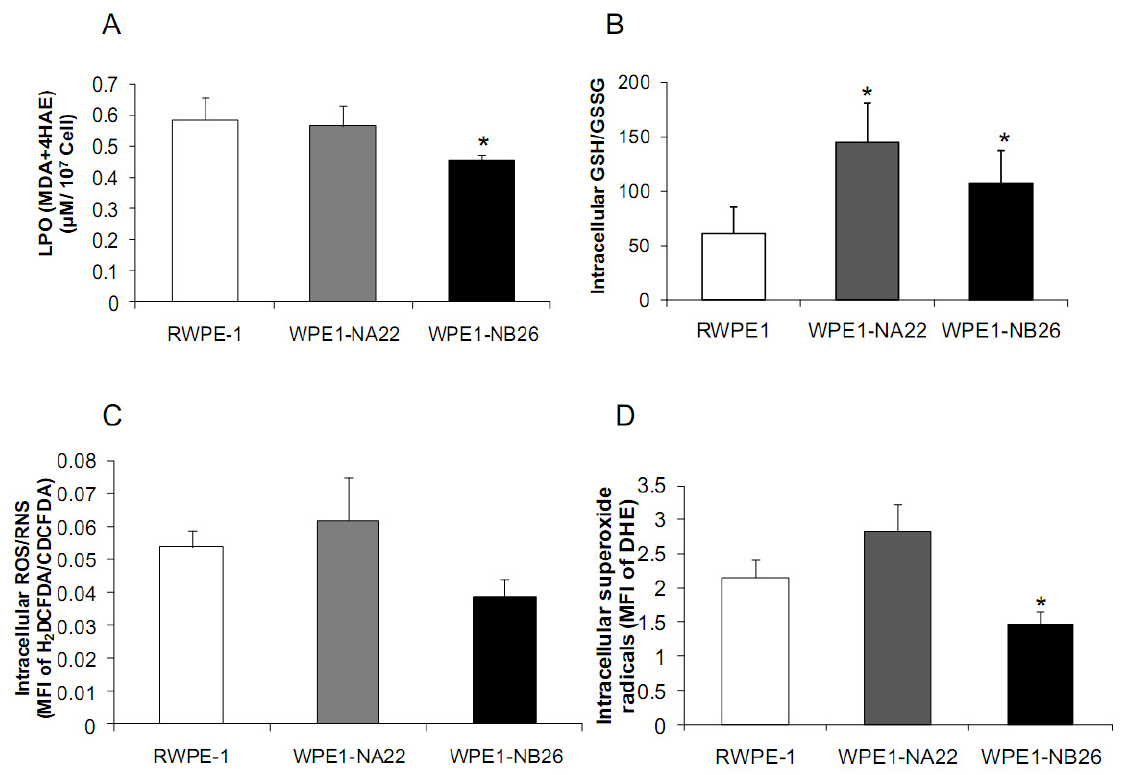
Figure 4. Intracellular redox state of RWPE1, WPE1-NA22, or WPE1-NB26 cells. ( A ) Lipid peroxidation levels . Cells were collected and cell lysates were measured for malondialdehyde (MDA) and 4-hydroxyalkenals (4HAE) levels using LPO-586 kit; ( B ) Intracellular GSH/GSSG ratios. Cells were cultured in KSFM without BPE and rEGF for 24 h. Cells were collected for GSH/GSSG assay; ( C ) Flow cytometry analysis of intracellular ROS/RNS levels. Cells were collected during log phase and incubated with 2',7'-dichlorofluorescein diacetate (H DCFDA). 5-(and-6)-carboxy-2',7'dichlorofluorescein 2 diacetate (CDCFDA, oxidation insensitive dye) was used to normalize uptake, efflux, and ester cleavage of H DCFDA; ( D ) Flow cytometry analysis of intracellular superoxide 2 radical levels. Cells (1 × 10 4 ) were collected during log phase and incubated with dihydroethidium (DHE). MFI = Mean fluorescence intensity. * P-value ≤ 0.05 when compared to